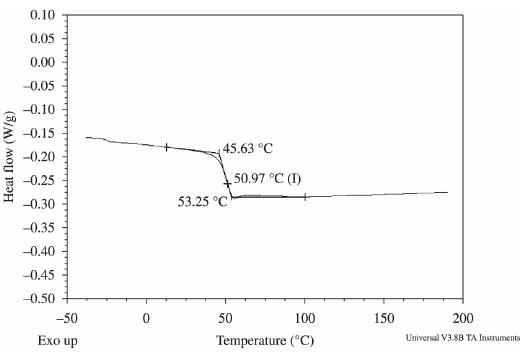
Figure 7. DSC thermogram for the second heating of PLDLA-TMC.